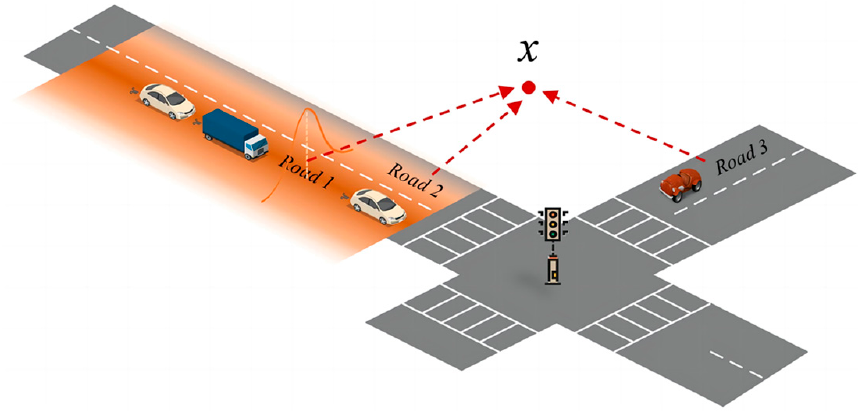
Figure 5. Effect of traffic emission dispersion on concentration at location x .